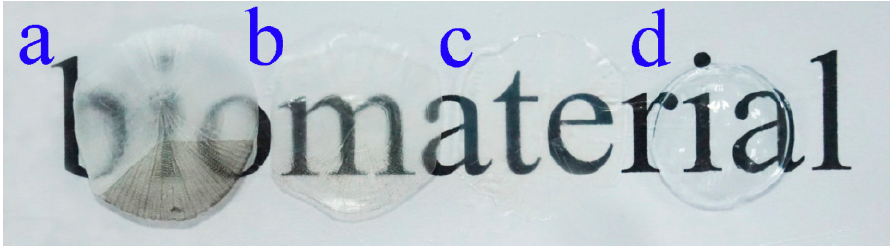
Figure 7. Digital photos of fresh fish scales ( a ), decalcified fish scales ( b ), fish scale collagen lamellar matrix ( c ) and contact lens ( d ).